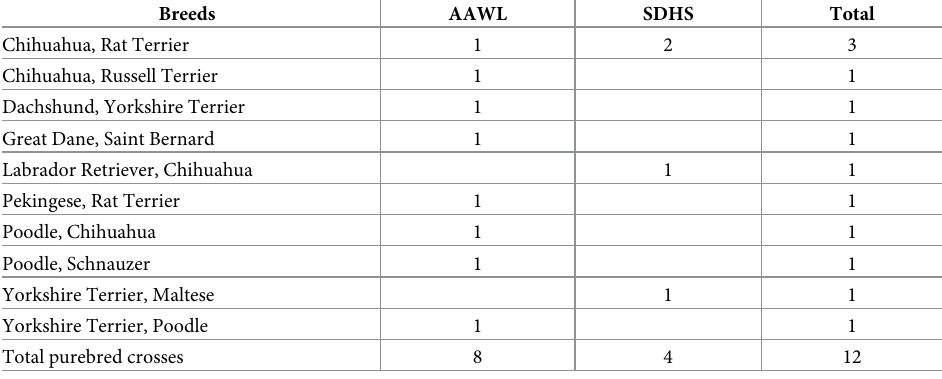
Table 2. Dogs at Arizona Animal Welfare League and San Diego Humane Society with two purebred parents of different breeds. Breeds AAWL SDHS